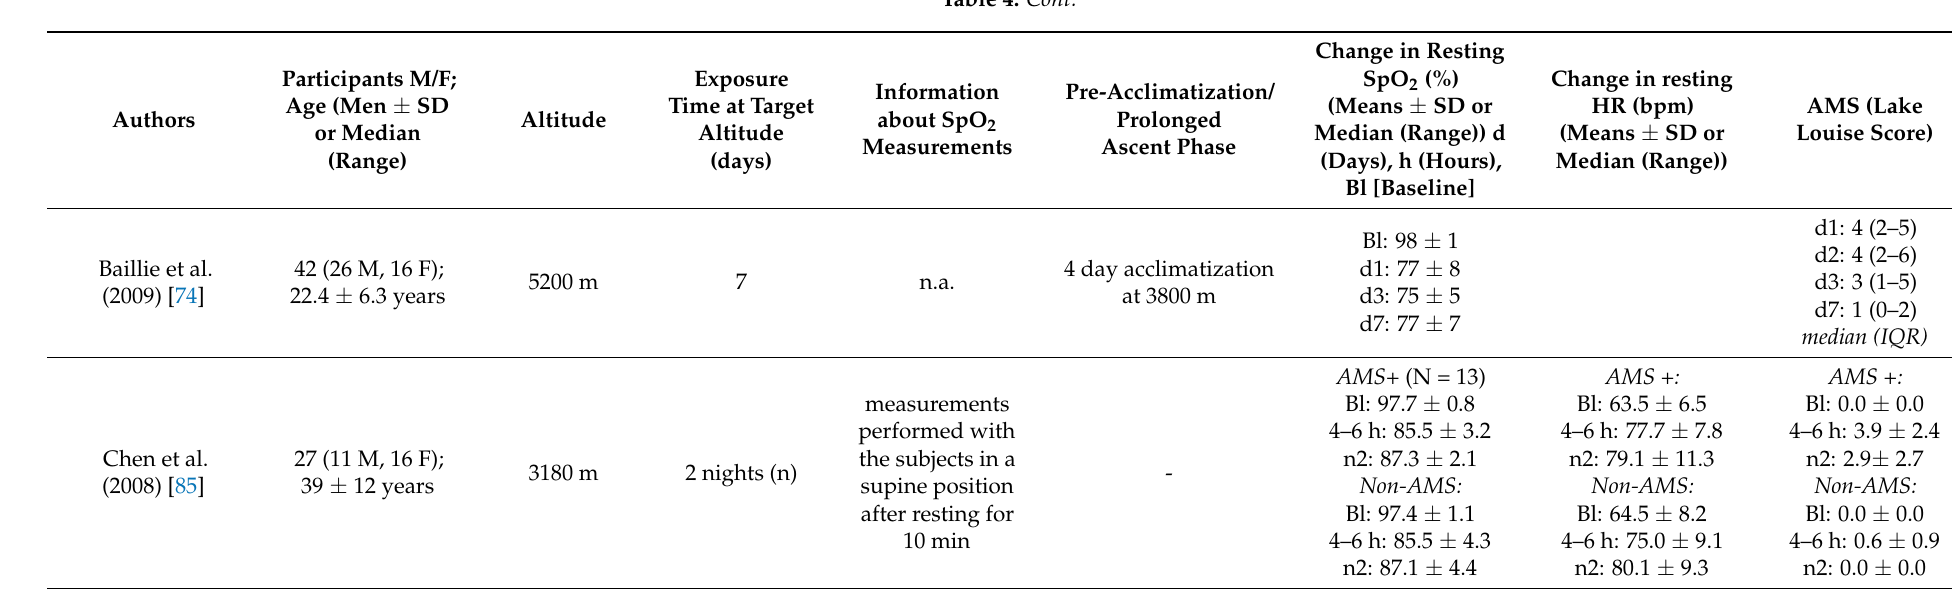
* data obtained from Figure. # control group. N.a. not